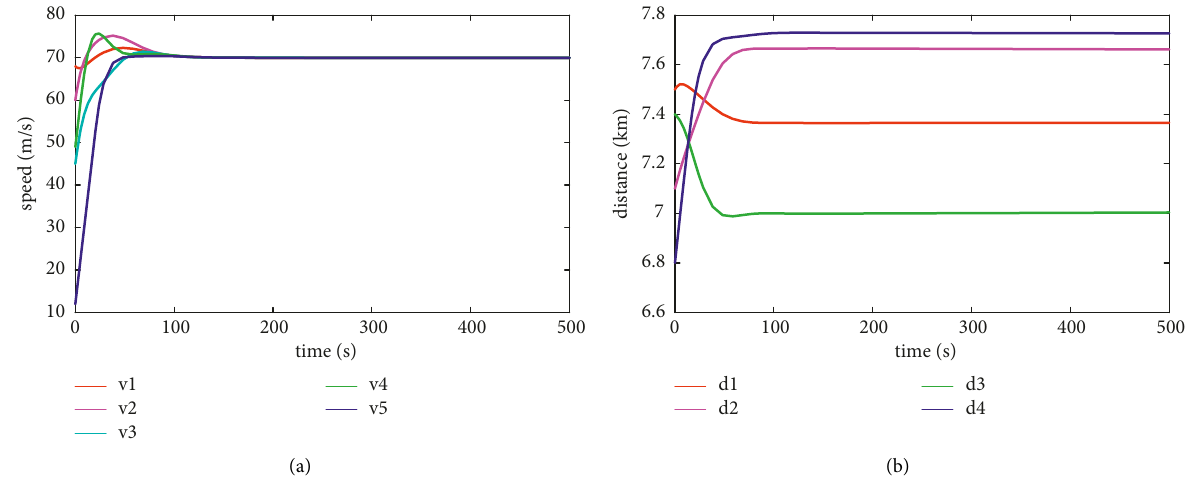
i th train and the ( i + 1 ) i represents the distance between the